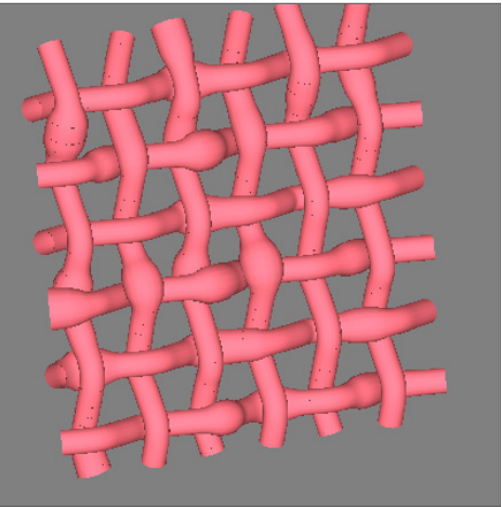
Figure 18. Woven structure with 3D slub yarns.